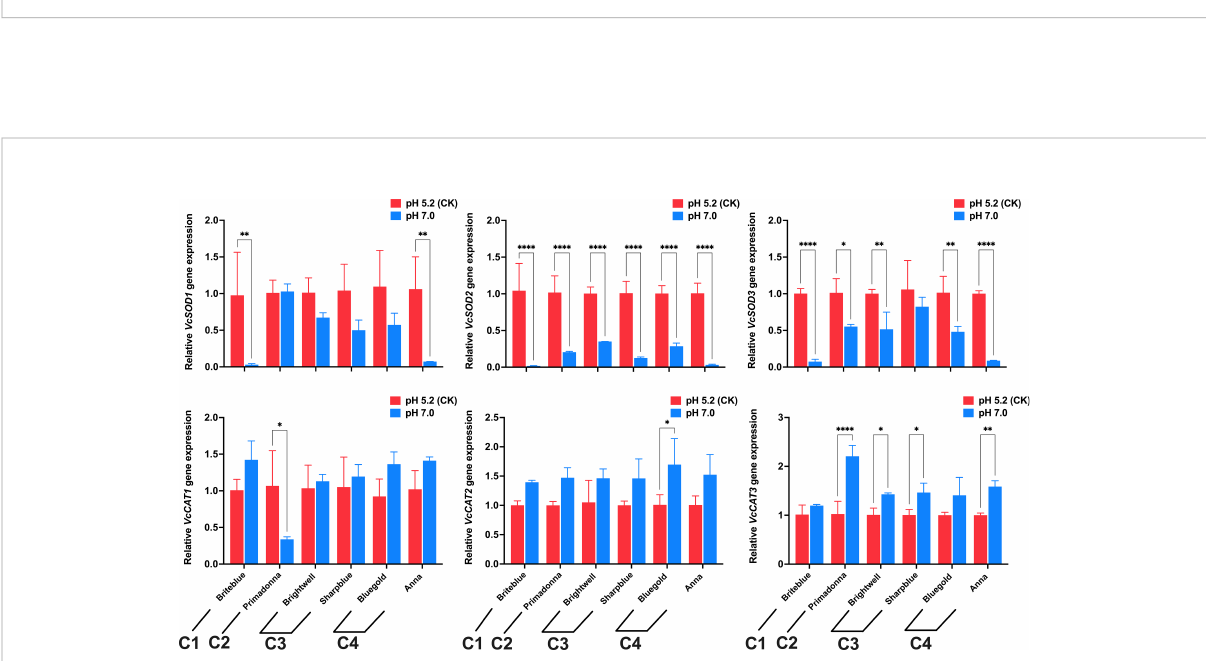
FIGURE 7 Effects of high soil pH stress on antioxidant system gene expression levels ( SOD and CAT ) in four types of high soil pH-tolerant blueberry leaves (6 cultivars). C1 represents high soil pH-tolerant blueberry cultivars, C3 represents low high soil pH-tolerant blueberry cultivars, C4 represents high soil pH-sensitive blueberry cultivars, and C2 represents intermediate blueberry cultivars. Values are expressed as the means ± SDs after 3 repetitions. * represents a signi fi cant difference at p<0.05, ** represents a signi fi cant difference at p<0.01, and **** represents a signi fi cant difference at p<0.0001, determined by Tukey ’ s test.